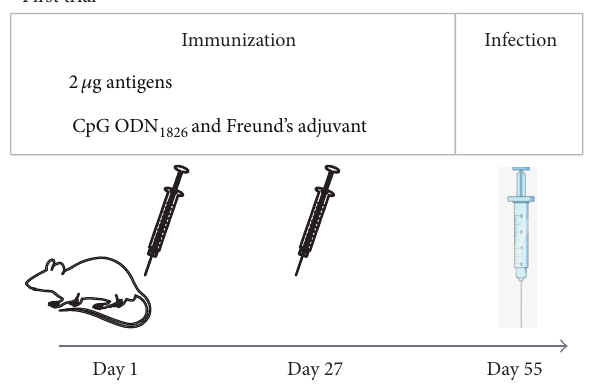
Figure 2: Experimental design of immunization with purified antigens and different adjuvants. IgGs, from naturally surviving ICR mice to PyL infection, were purified and used to isolate blood-stage parasite antigens. BALB/c mice divided into 6 groups were then inoculatedwith2 𝜇 gofpurifiedantigensusingCpGODN 1826 and/or Freund’s adjuvant systems or with proper controls on days 1 and 27 and infected with 2 × 10 7 PyL- RBCs on day